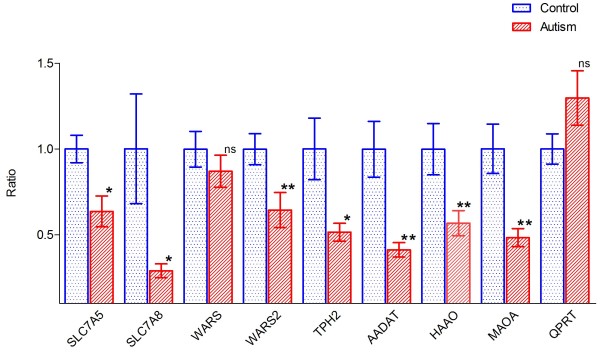
Histogram of gene expression of selected genes in tryptophan metabolic pathway in the ASD cells vs. control cells. The bar height of the histogram indicates the mean of measurements of 10 cell lines for the controls and 10 cell lines of patients with ASDs. Vertical bars are standard errors of the means. Symbol denotes level of statistical significance determined by a t test: *P <0.05; **P <0.01. ns, non-significant.